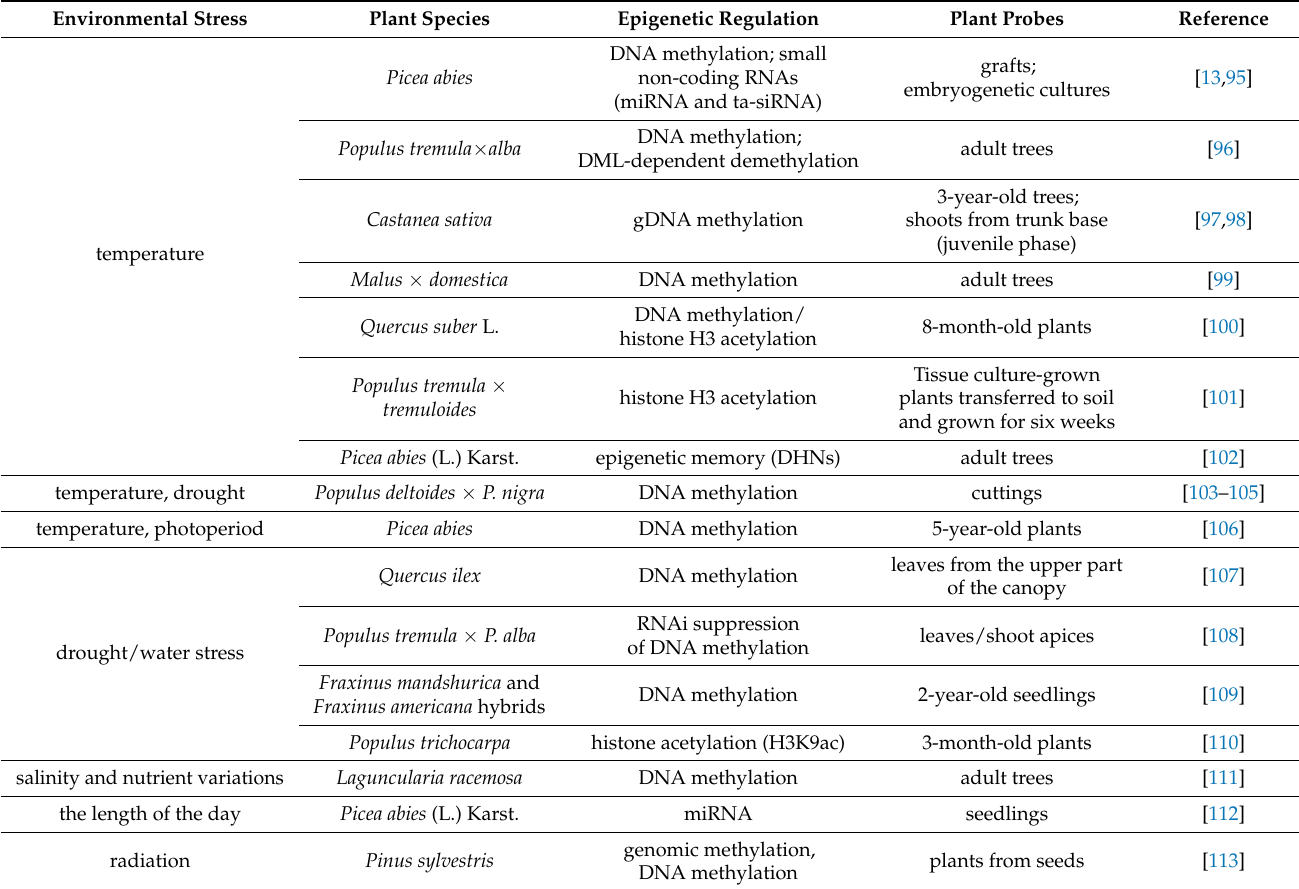
Table 1. Selected epigenetic modifications of trees under the influence of environmental